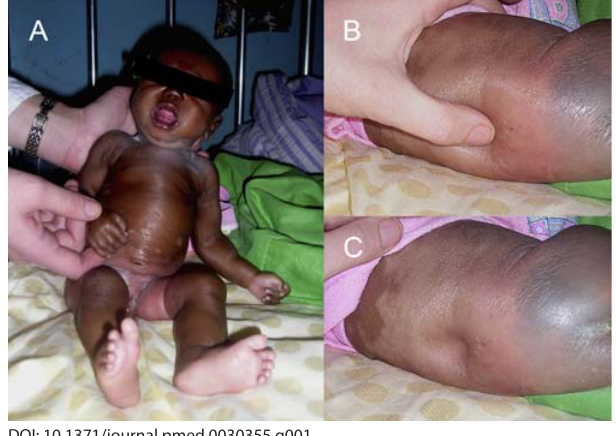
Figure 1. Photographs of the Patient Soon after Admission, Showing Generalised Oedema (A) shows the frontal view. (B) and (C) demonstrate oedema of the